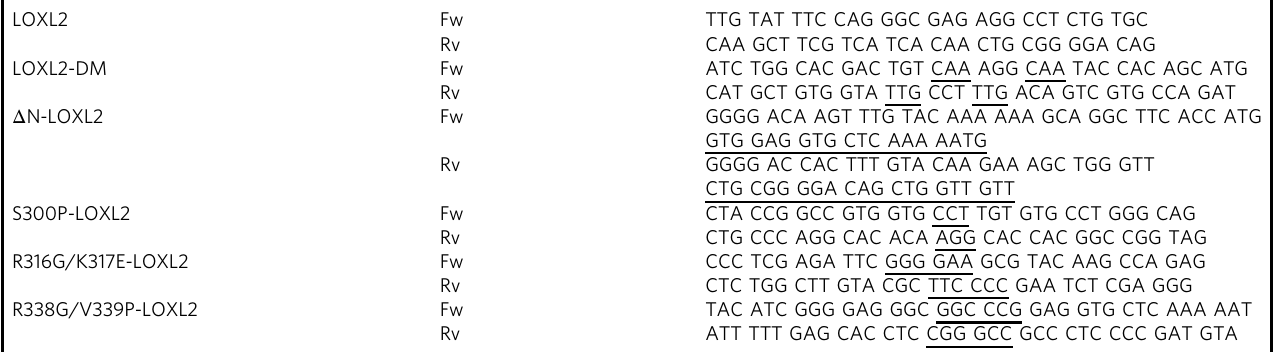
Table 1 PCR primers used for cloning and site-directed mutagenesis.